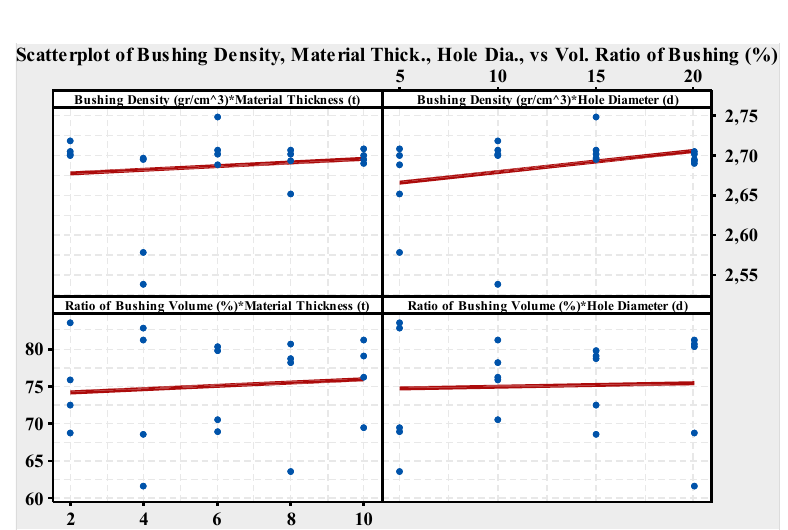
Figure 9. The effects of hole diameter and material thickness on mean a ) bushing height, b ) bushing wall.